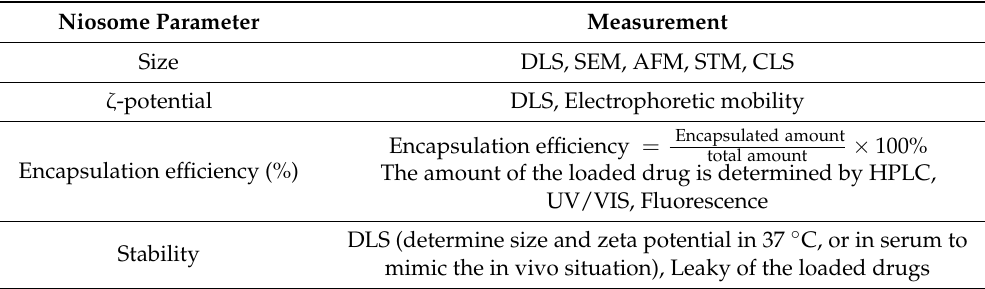
Table 2. Methods for characterization of niosomes.